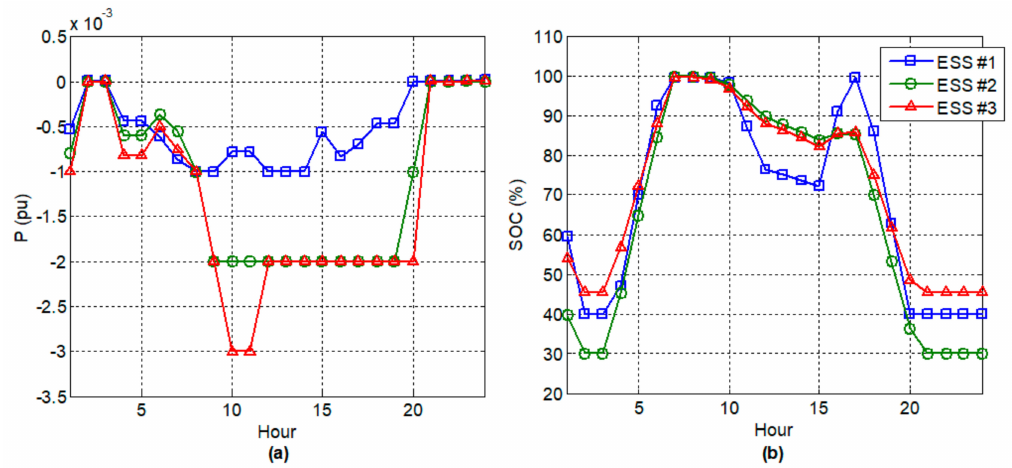
Figure 13. Case III. ( a ) Discharging profile and ( b ) the SOC of each ESS for harmonic compensation. The required reference currents of the ESSs at each period are determined in the ESS-AHF model.